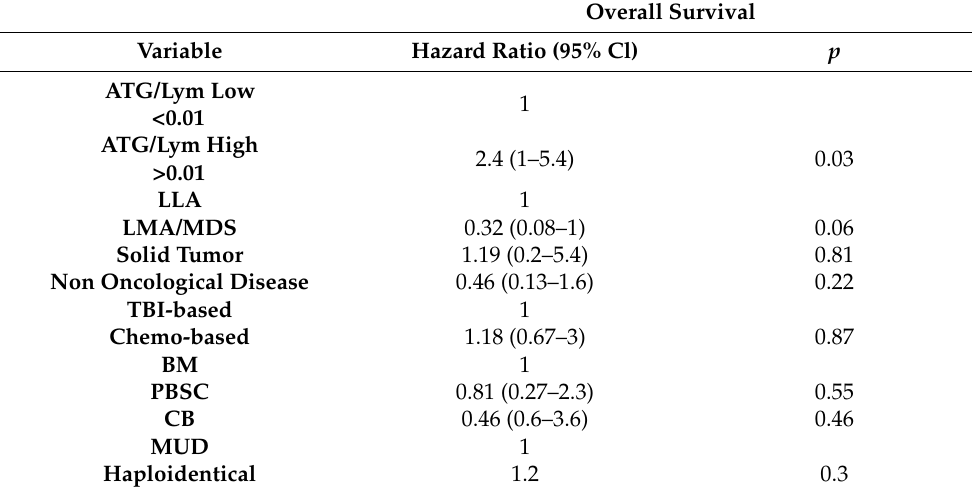
Table 3. Multivariate proportional hazards regression analysis for overall